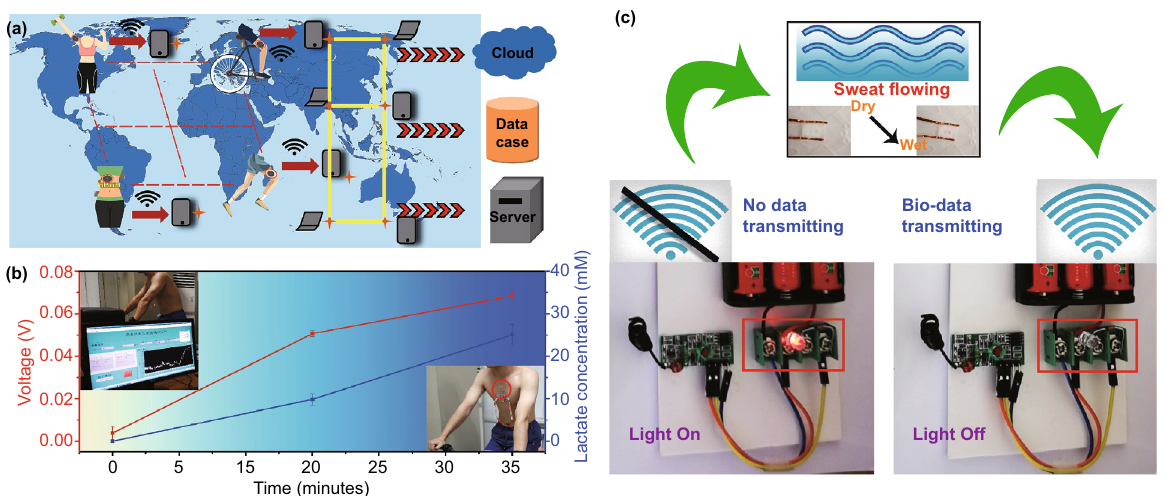
Fig. 5 a Potential application scenarios of the devices integrated with wireless transmitters. b Experimental results of human sweat analysis. c Simple wireless system integrated with perspiration analyzing